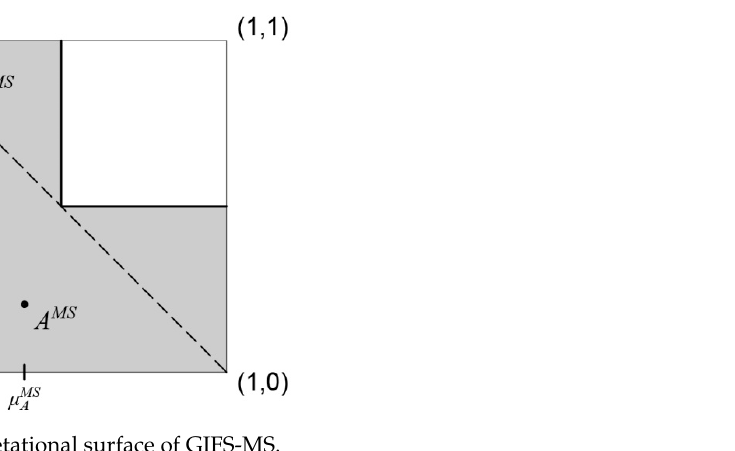
Figure 4. Interpretational surface of GIFS-MS.